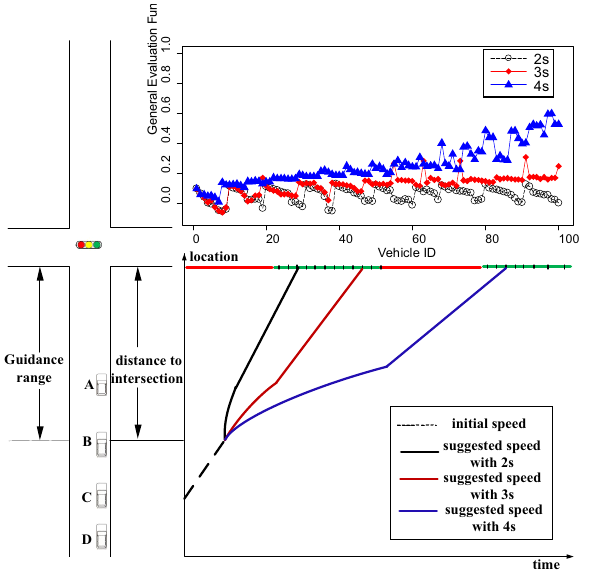
Figure 12 GEF value of model with 2s, 3s and 4s section lengths under 100% PR